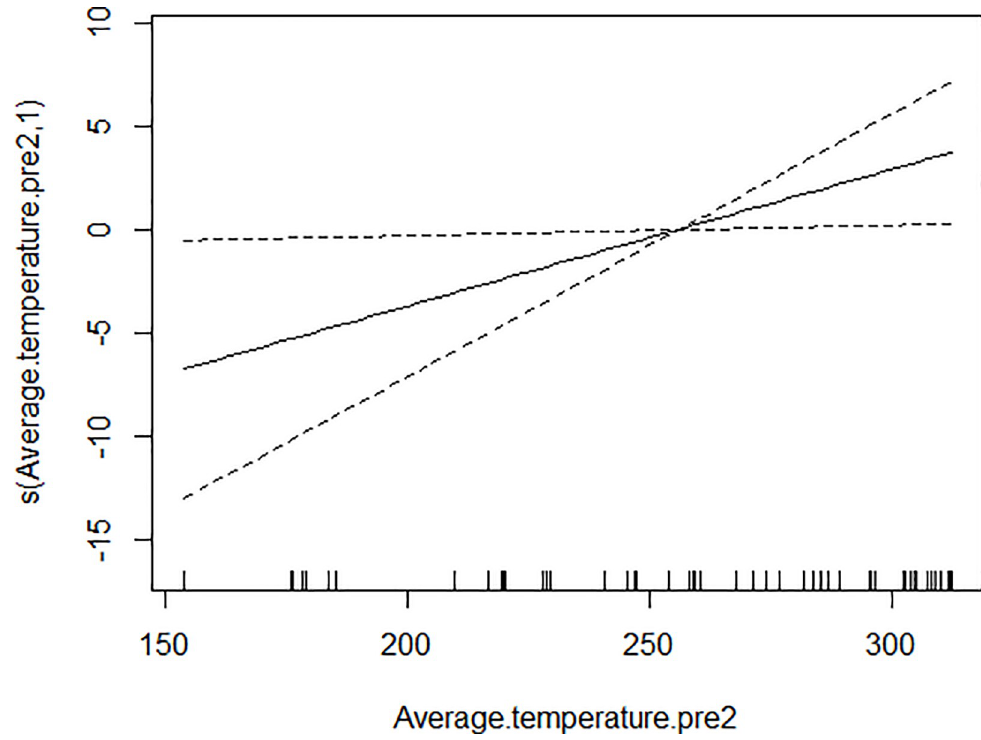
Fig 8. The relationship between Ae . albopictus density and average temperature pre 2 weeks.